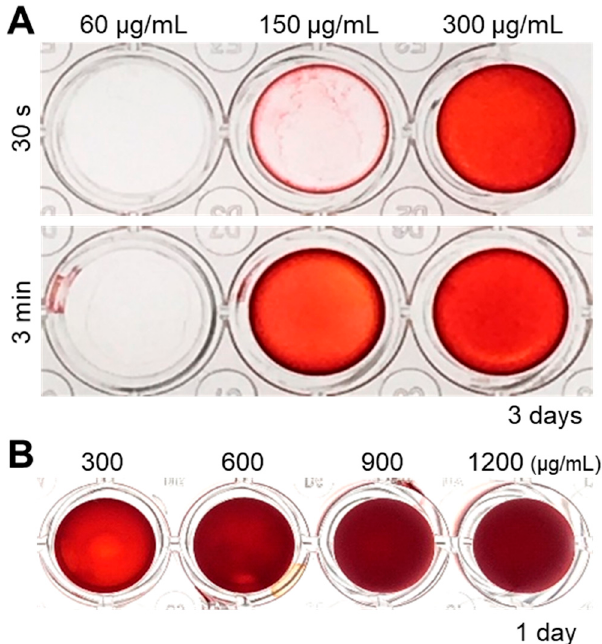
Figure 5. ( A ) Analysis of the optimal concentration of cell nanofragments obtained from ATDC5 cells. Cell nanofragments at different concentrations (60 µg/mL, 150 µg/mL, and 300 µg/mL) were incubated in α -MEM supplemented with 10 mM β -glycerophosphate ( β -GP) for 3 days. ARS staining demonstrates the rapid mineralization of the cell nanofragments obtained by 3 min ultrasonication, compared to those obtained by ultrasonication 30 s. After 3 days of incubation, the concentration of 150 µg/mL (ultrasonication 3 min) was the minimum amount of nanofragments necessary to obtain a thin and homogeneous mineralized layer. ( B ) ARS staining of cell nanofragments incubated for 1 day at concentrations above 300 µg/mL. The concentration of 300 µg/mL was the minimum amount of nanofragments required to obtain a thin and homogeneous mineralized layer after 1 day of incubation. Concentrations above 300 µg/mL showed a thick layer, which could be retaining small amounts of the ARS compound inside.